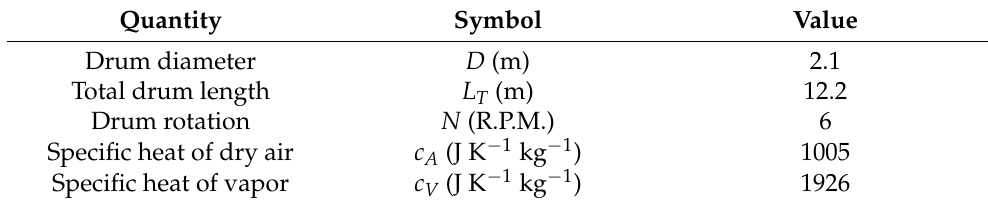
Table 1. Geometric and operational data of the rotary drum dryer.